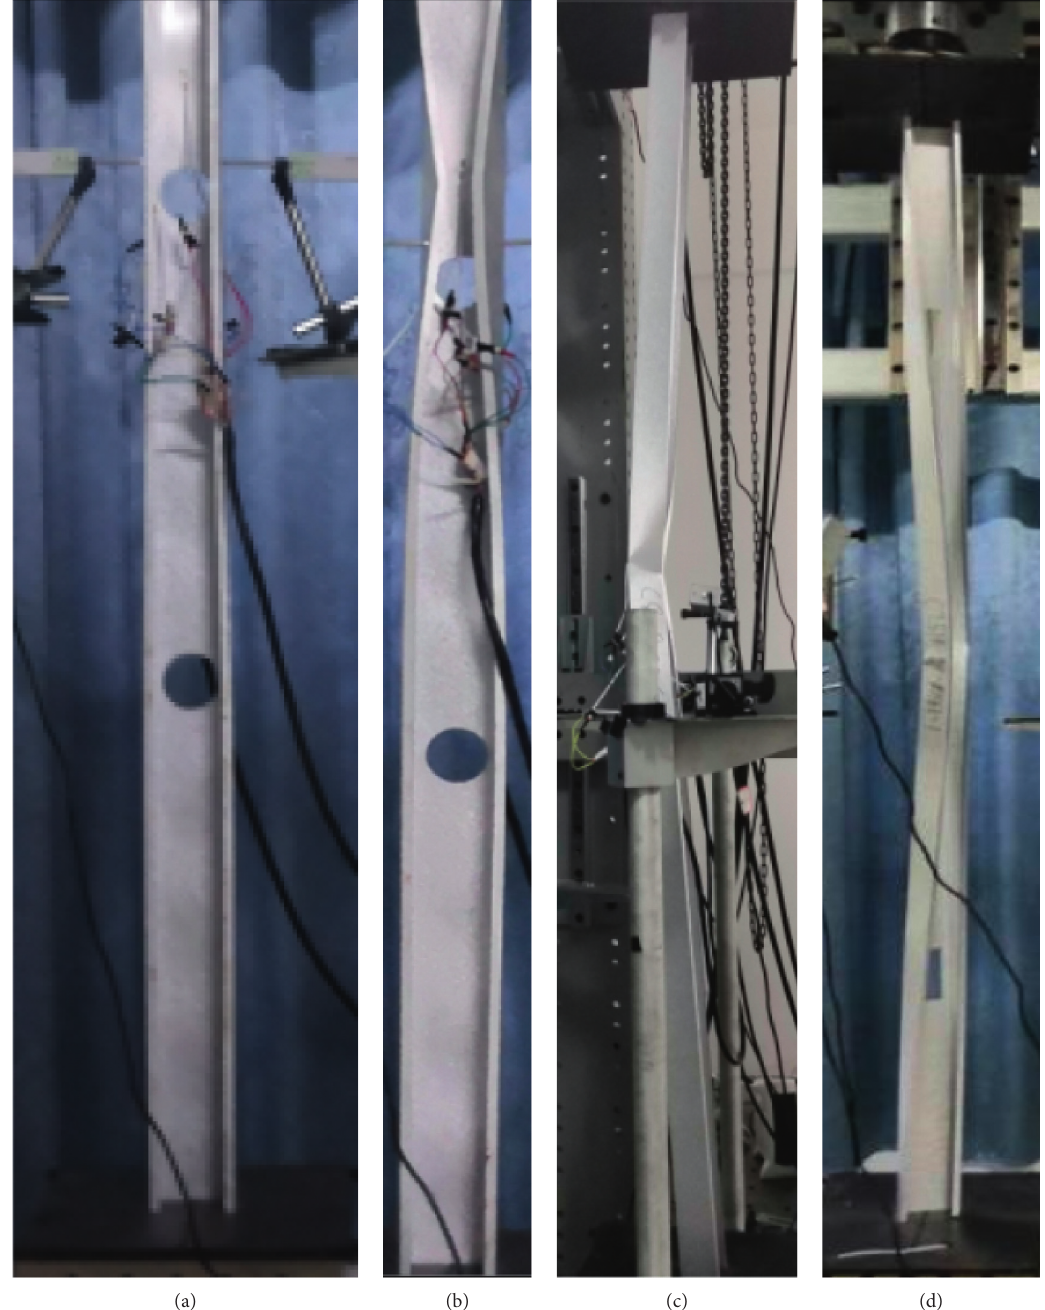
Figure 11: Buckling modes of specimens with a length of 2000mm. (a) Local buckling. (b) Distortional buckling. (c) Flexural buckling. (d) Flexural-torsional